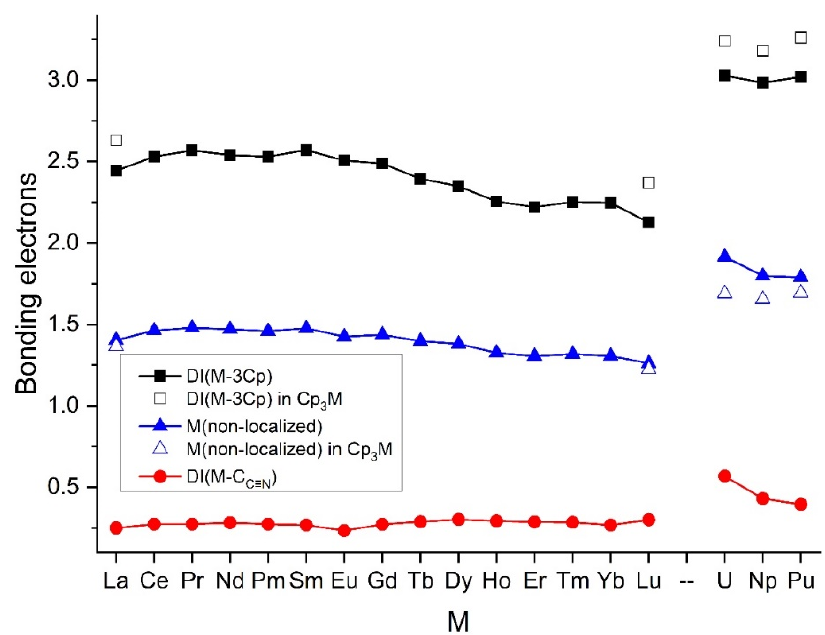
Figure 7. Delocalization indices between M and the contacting C atoms of the ligands as well as non-localized electrons on M in the (Cp) 3 M(C ≡ NCy) and selected (Cp) 3 M